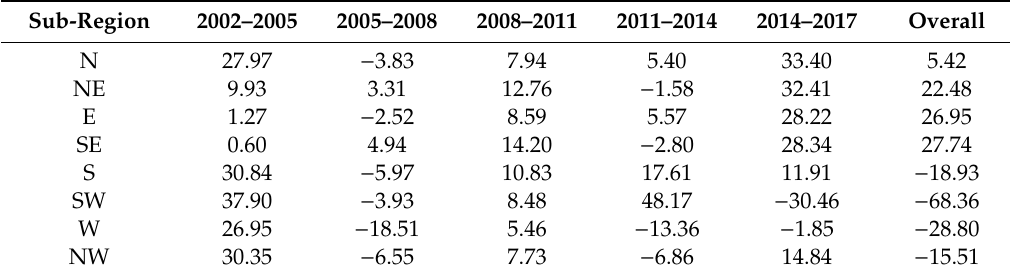
Table 11. The variations of ISCIs in the eight